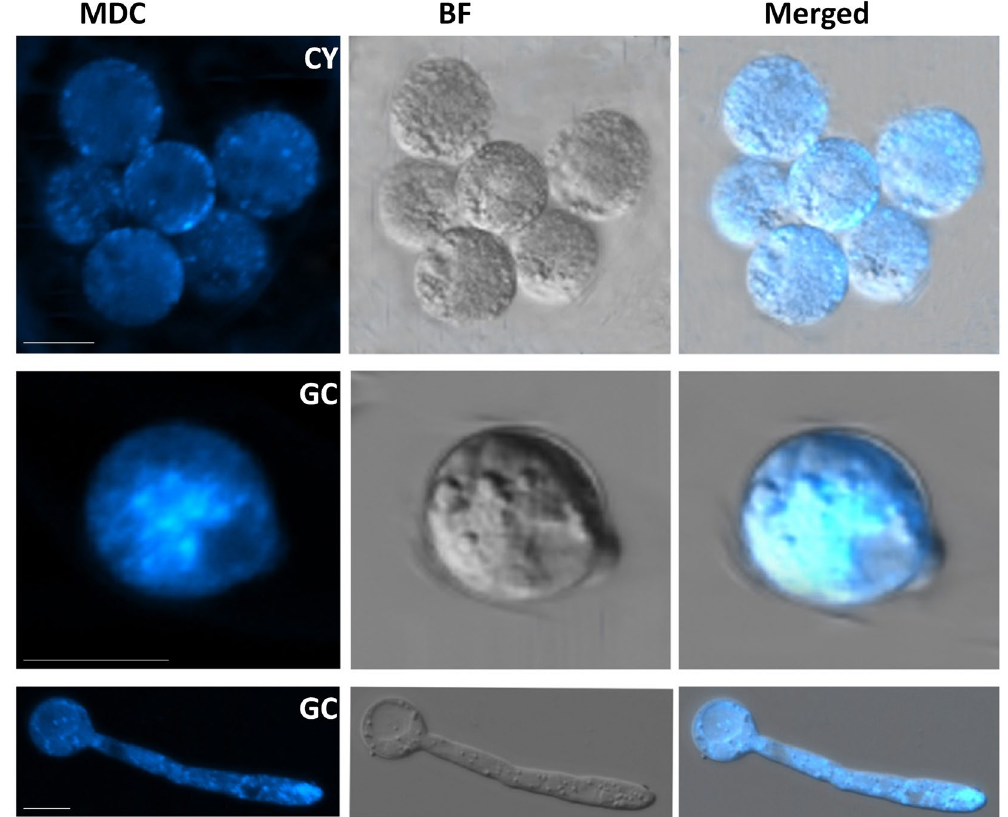
Figure 7. Autophagosome formation in the germinating cyst stage of P. sojae . Visualization of autophagy activation with MDC in cysts (CY) and germinated cysts (GC) of P . sojae . Cyst and germinated cyst samples were collected, concurrently stained with MDC, and analyzed by confocal microscopy. Bars = 10 μ